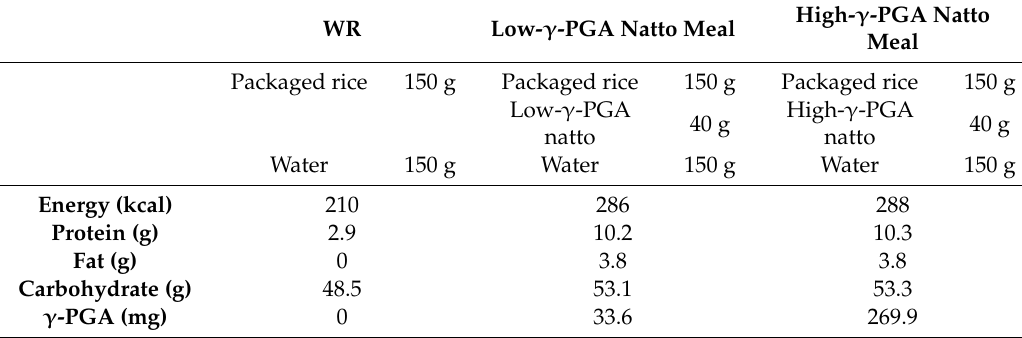
Table 1. Composition and components of each